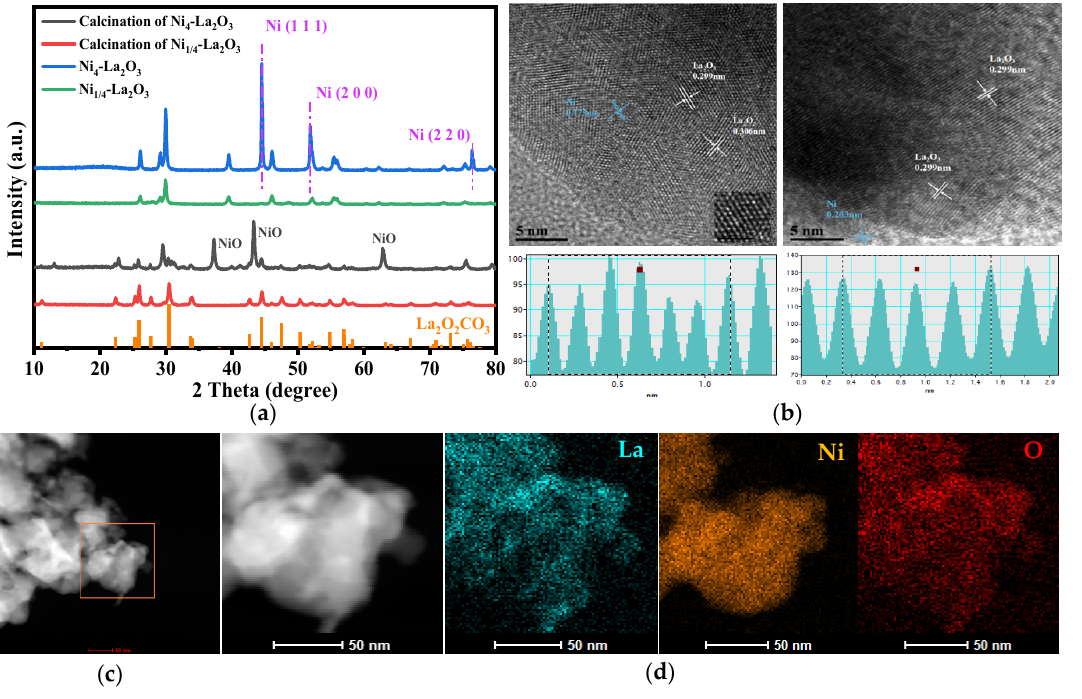
Figure 1. ( a ) XRD pattern of Ni x -La 2 O 3 samples, ( b ) HRTEM images of Ni 4 -La 2 O 3 and Ni 1/4 -La 2 O 3 , ( c ) STEM-HAADF image, and ( d ) element mappings of the Ni 4 -La 2 O 3